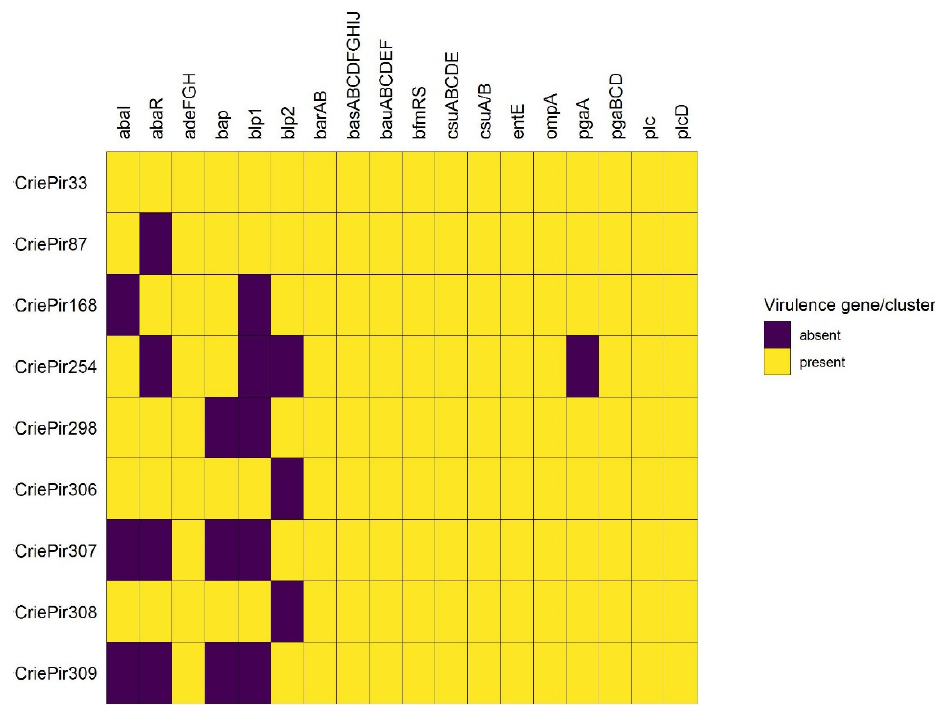
Figure 3. Virulence factors of the A. baumannii isolates studied. Genes constituting the same cluster presented in all isolates were combined for the sake of brevity. abaI, abaR—components of the